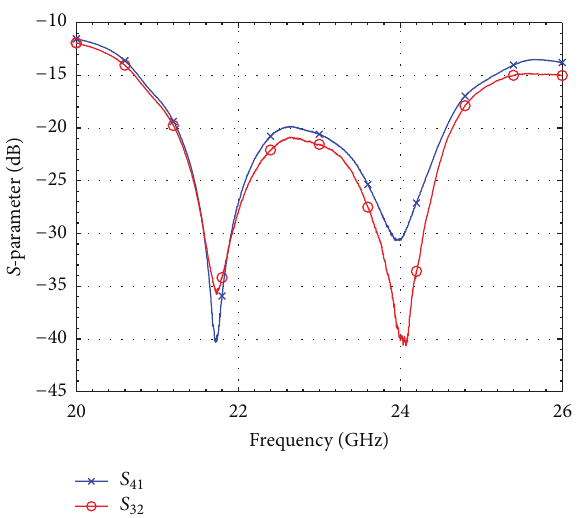
Figure 13: Measured 𝑆 41 and 𝑆 32 of the hybrid coupler.